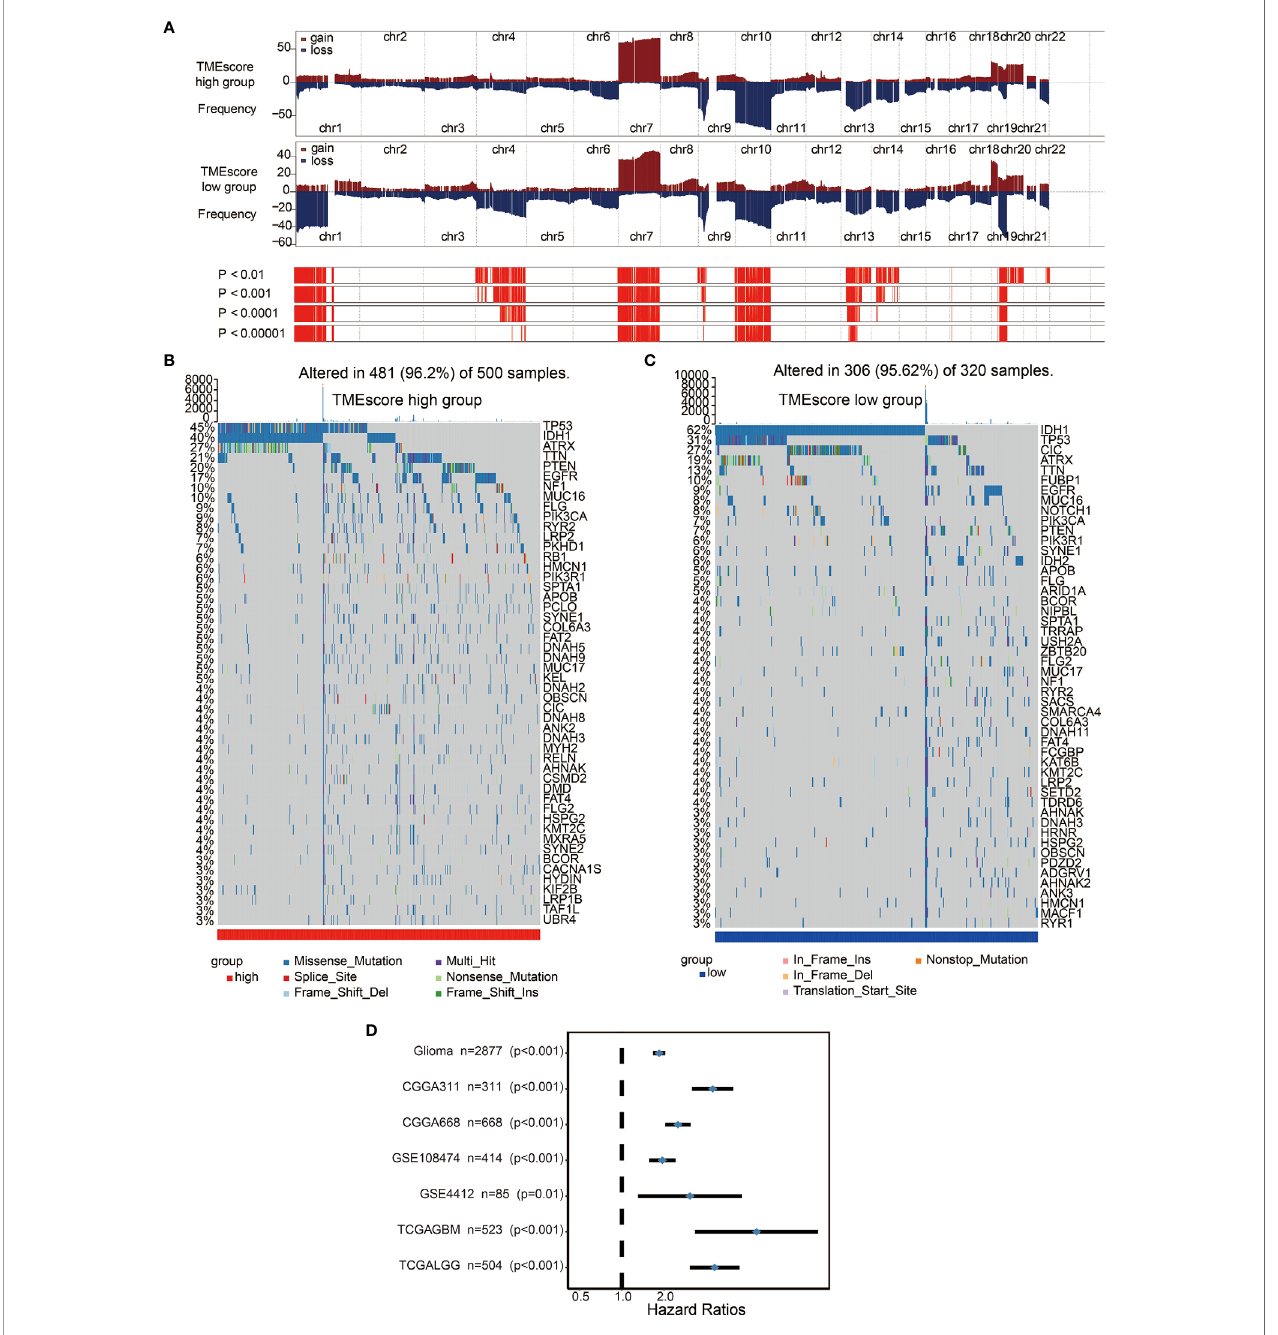
FIGURE 4 | Distinct genomic pro fi les associated with the TME-score. (A) GISTIC 2.0 ampli fi cations and deletions in gliomas with high and low TME-scores. Chromosomal locations of peaks of signi fi cantly recurring focal ampli fi cations (red) and deletions (blue) are presented. (B) Differential somatic mutations were detected in gliomas with high TME-score. (C) Differential somatic mutations were detected in gliomas with low TME-score. (D) Subgroup analyses estimating the clinical prognostic value between low/high TME-score groups in independent glioma